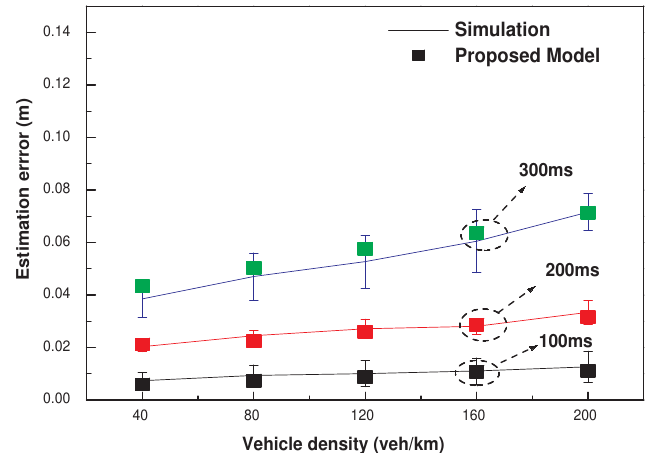
Figure 4. Comparison between numerical results of our model and those of the NS-2 simulation as a vehicle density varies with various a beacon interval settings: (1) 100 ms and (2) 200 ms, and (3) 300